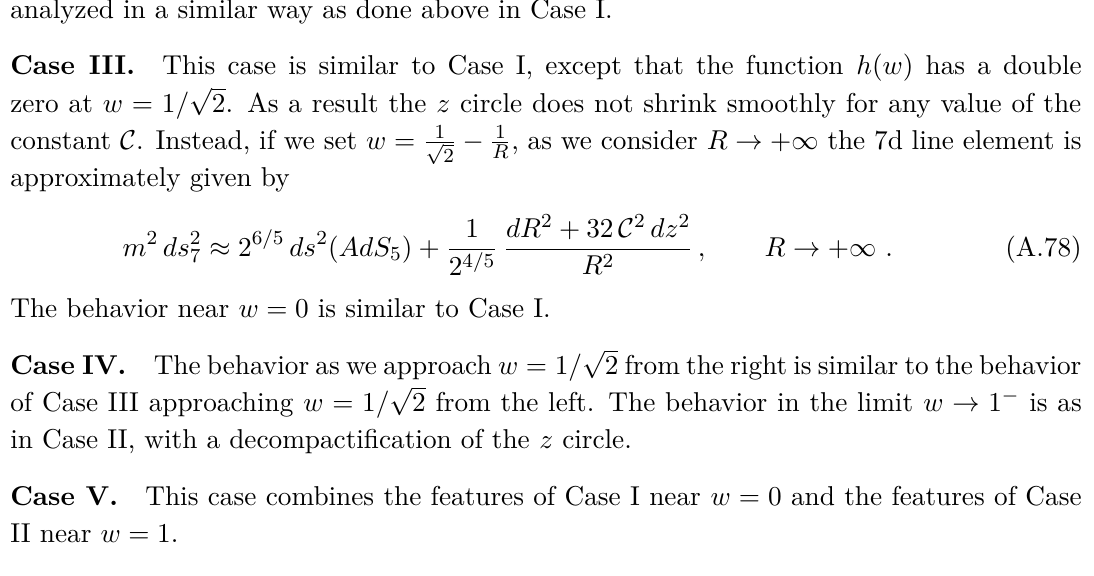
‘ warp function 5